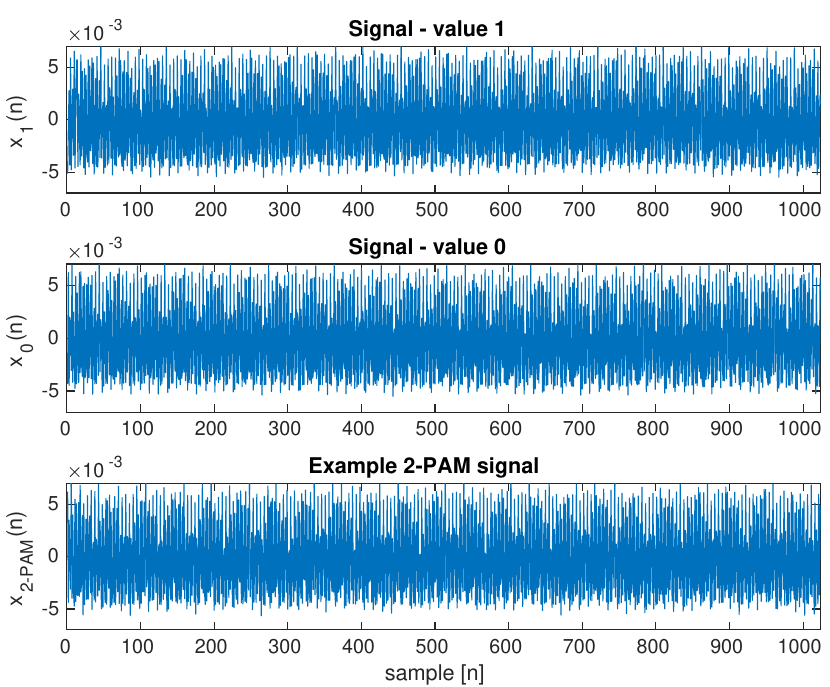
Figure 16. Waveforms for the average brightness of video sequence frames. Waveforms for two brightness levels and a random transmitted sequence with 2-PAM modulation are shown. Brightness modulation with LCD backlight. Scenario with strong brightness